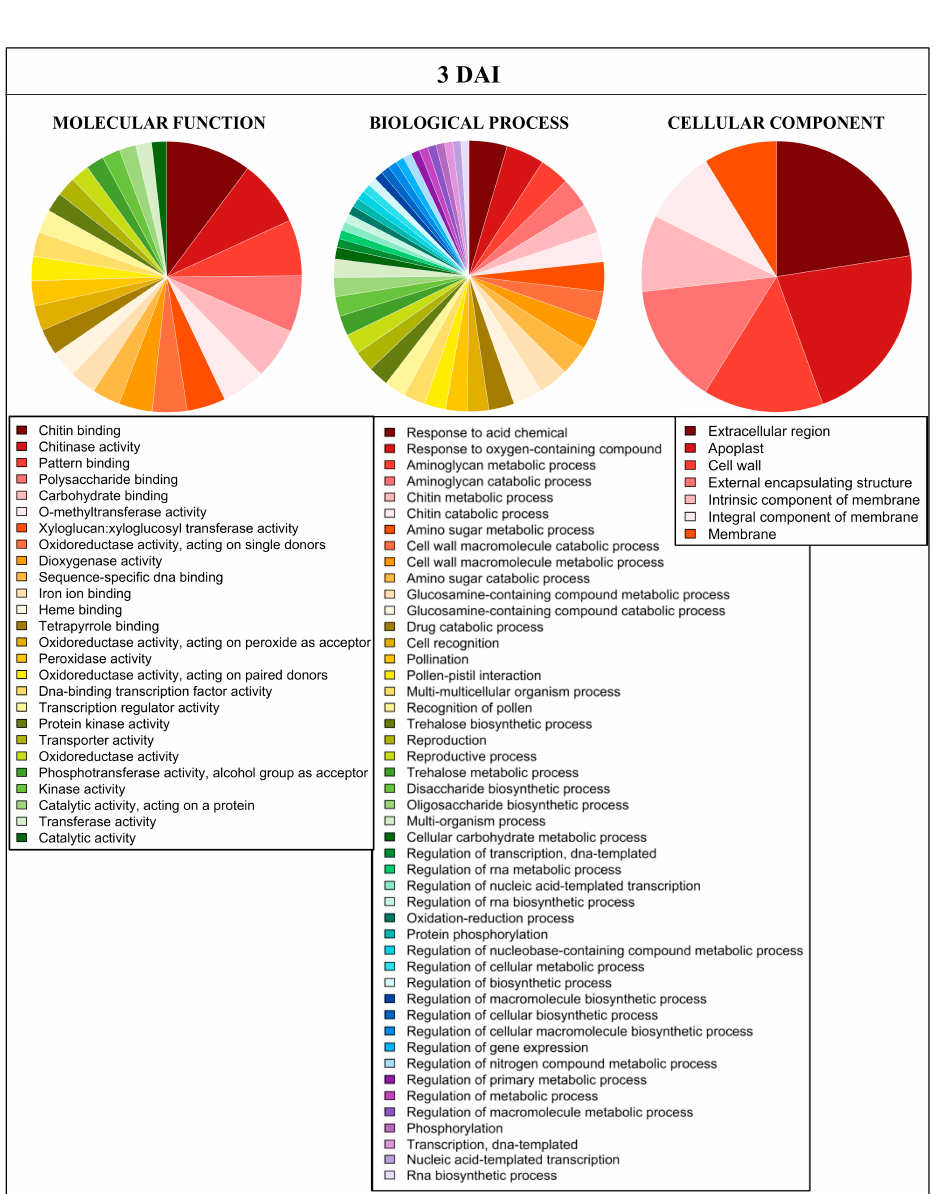
Figure 2. Distribution of gene ontology terms enriched across the three principal categories for differentially expressed genes in Musa acuminata var. Calcutta 4, 3 days after inoculation with Pseudocercospora musae . Differential expression data were based on log2FC of transcripts from inoculated plant tissues versus non-inoculated controls.